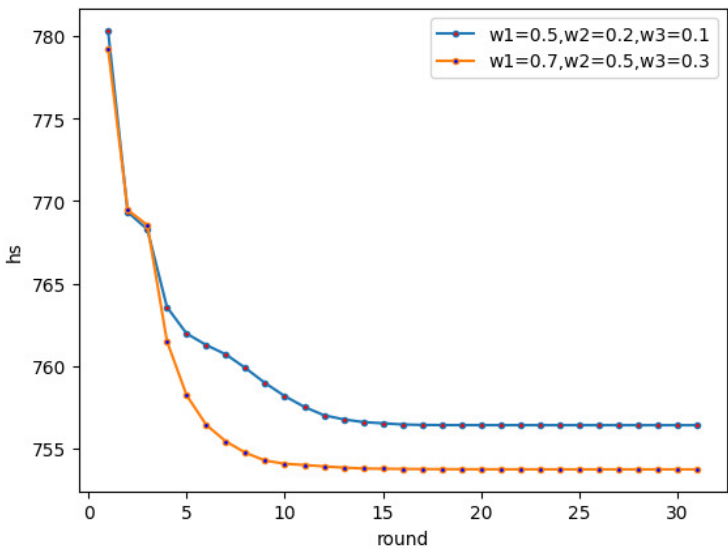
Figure 10. Effect of w 1 : h s changes with time.